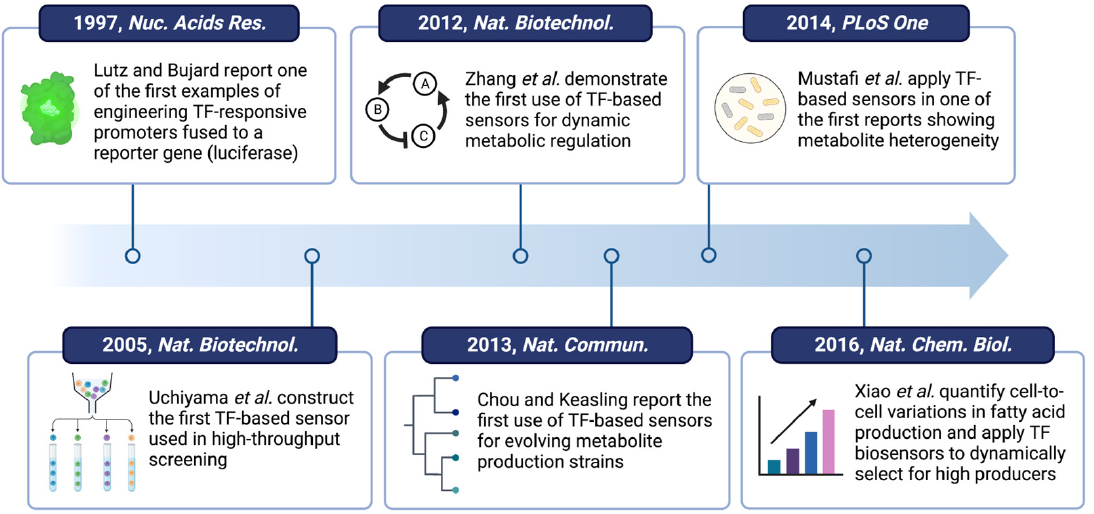
Figure 4. Roadmap of notable work related to the development and application of TF-based metabo- lite biosensors [77,86,94–97].